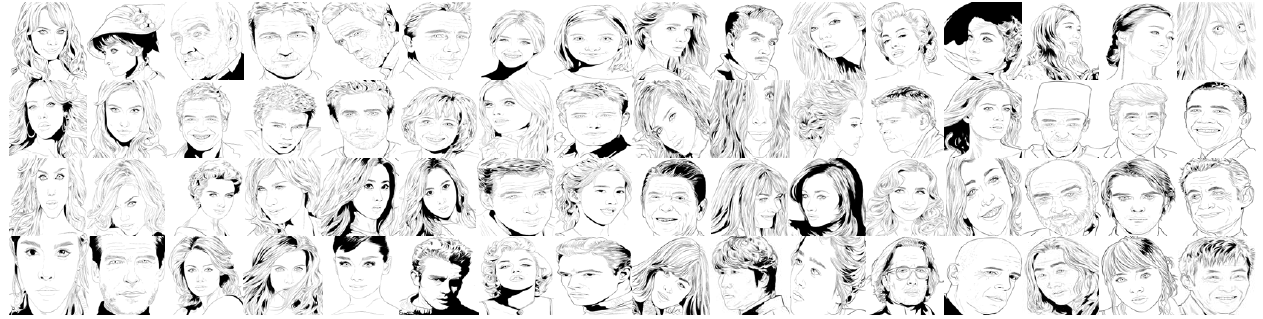
Figure 7. The training dataset of our